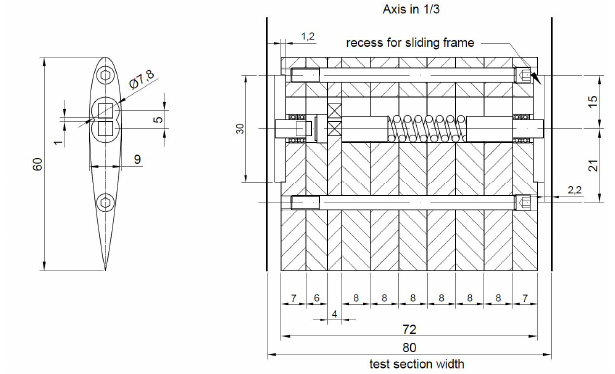
Fig. 6. The scheme of divided profile NACA 0015 with elastic element and rotary encoder.